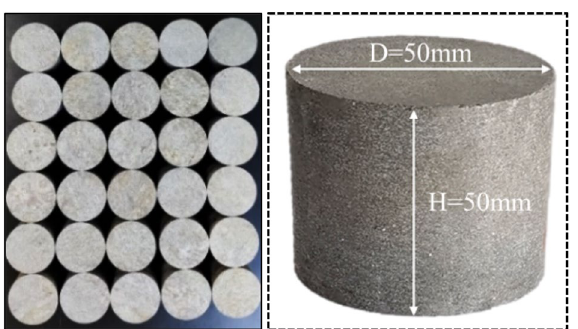
Figure 1. Graphite ore rock samples.